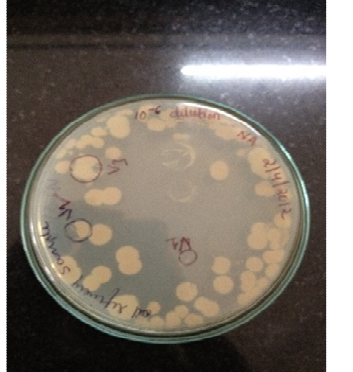
Figure 1. Isolation and screening of lipase-producing bacteria on tributyrin agar plate for VSH 09.